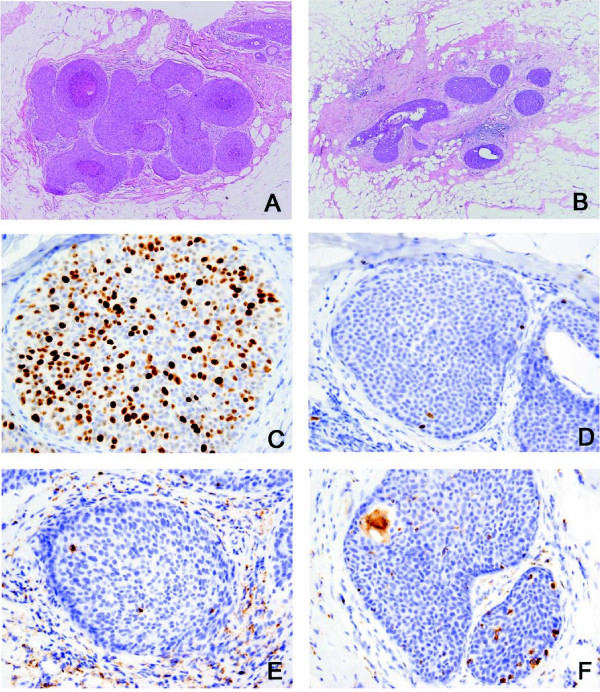
Histology of baseline (A, C, E) and endocrine-treated (B, D, F) DCIS from patient H-20 (magnification: 100×). A, B: H&E stain of baseline (A) and treated (B) samples. The treated DCIS is less distended and demonstrates increased periductal sclerosis and inflammation compared to baseline. C, D: Ki67; reduction in Ki-67 after treatment compared to baseline; E, F: CD68 (inset: 400×); increased CD68-positive macrophages after treatment compared to baseline.